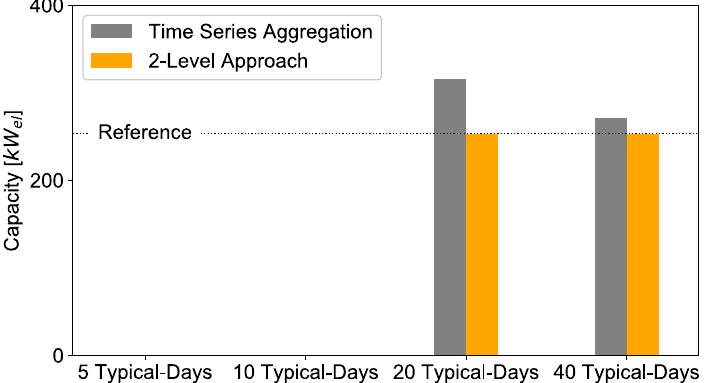
Figure 18. Deviation of installed fuel cell capacities with the 2-Level Approach and time series aggregation compared to full time series.